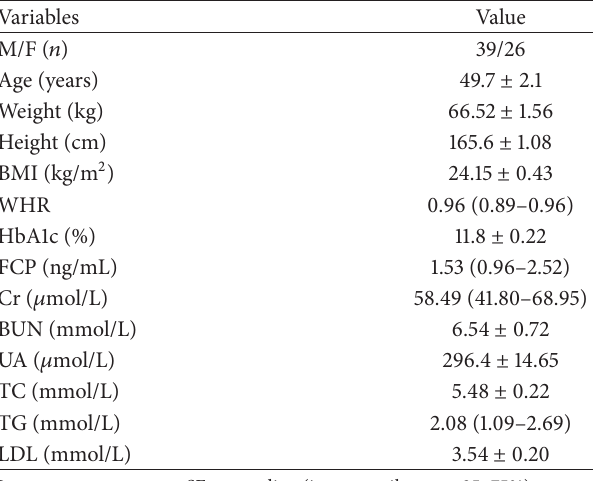
Table 1: Clinical characteristics of the